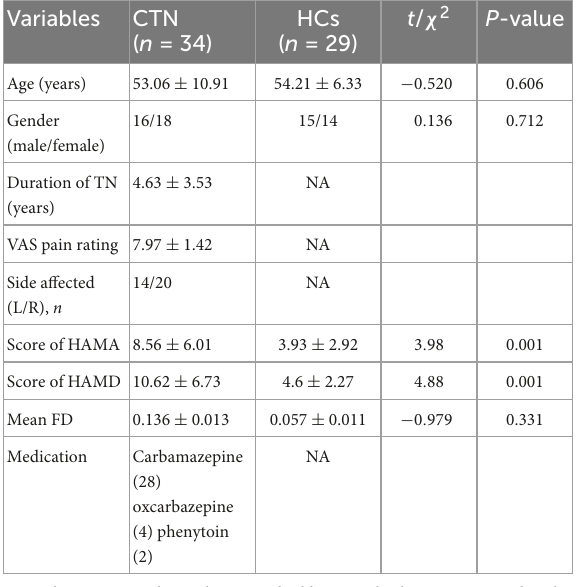
TABLE 1 Demographic and clinical characteristics of the